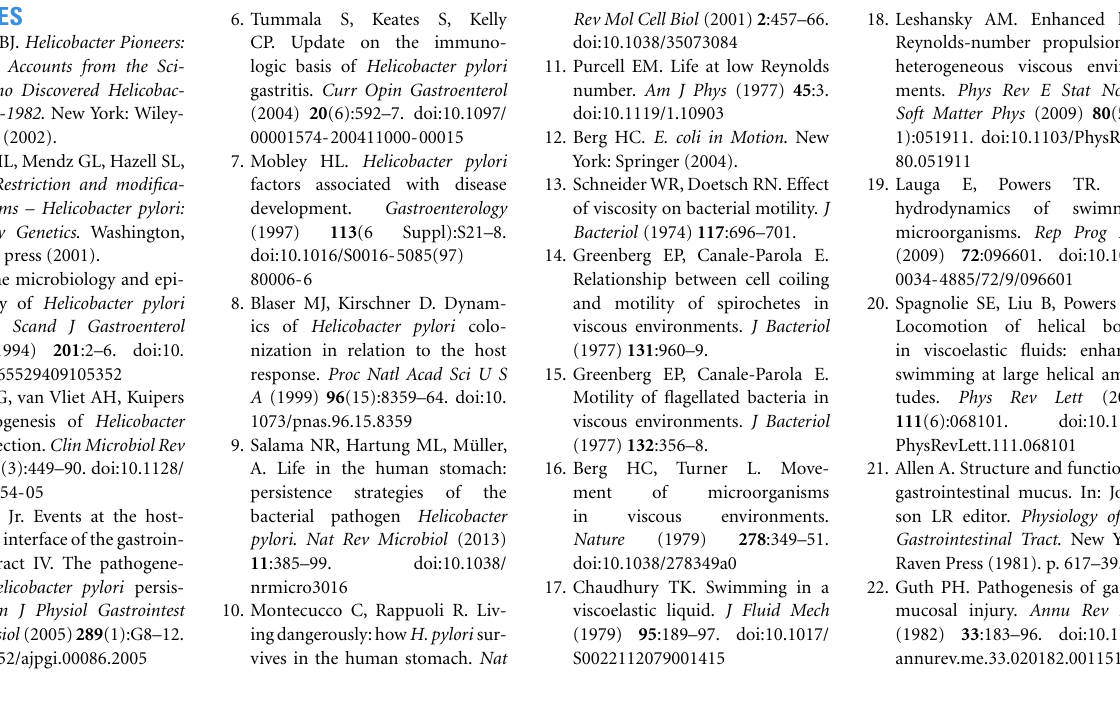
molecular biology, genetics, immunology, and the availability of mutants with specific molecular and functional alterations, will enable deeper understanding of this fascinating